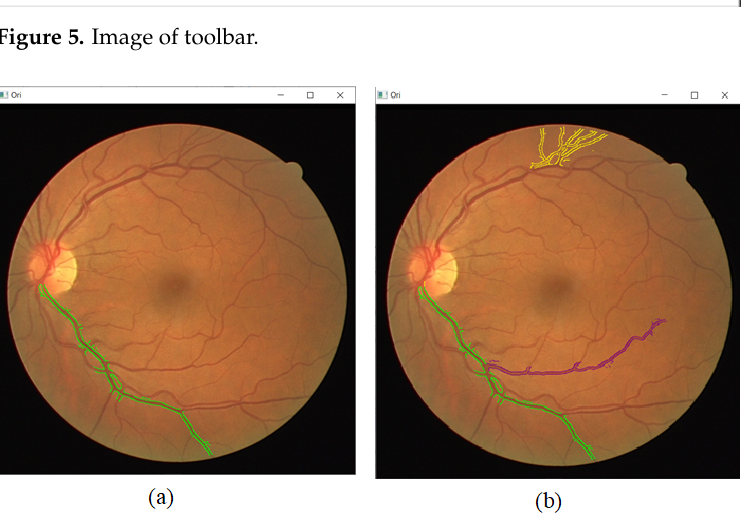
Figure 6. ( a ) Automatic edge detection is done on a vessel when a cursor is moved along it. ( b ) Multiple colors are used to categorize and differentiate the vessels for